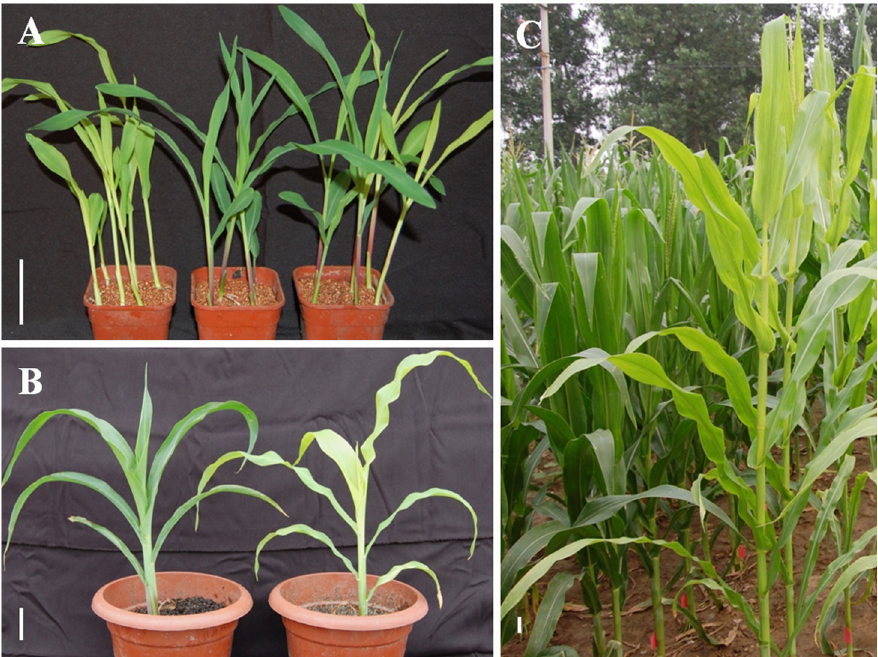
Figure 1. Phenotypes of the wild-type line Zheng58, the mutant elm2 , and the F plants. A, 10 d elm2 mutant seedlings (left), 2 Zheng58 wild-type seedlings (middle), and F seedlings (right). B, 4-week-old Zheng58 seedlings (left) and elm2 seedlings (right). C, 2 2-month-old Zheng58 adult plants (left) and elm2 adult plants (right) at the tasseling stage. Scale bar=5 cm.